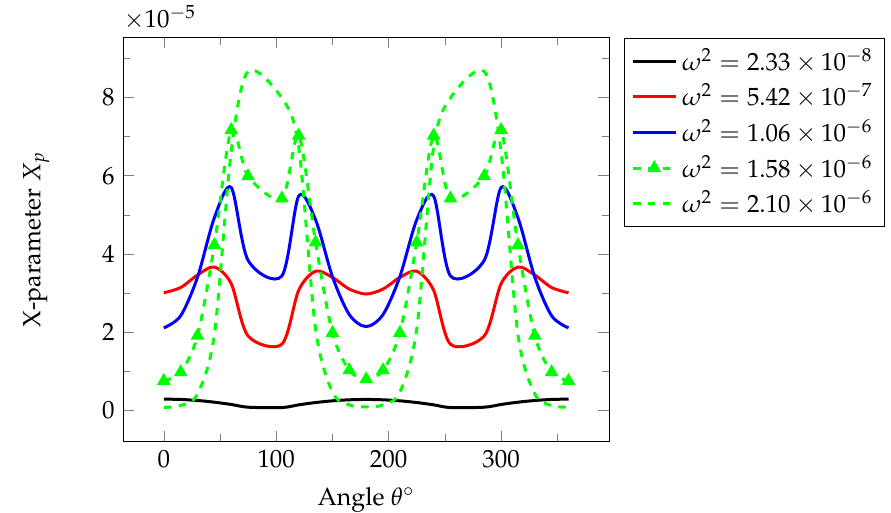
Figure 4. X -parameter ( X p ) as a function of angle ( θ ◦ ) at a fixed time t = 10 d and varying separation constant ( ω 2